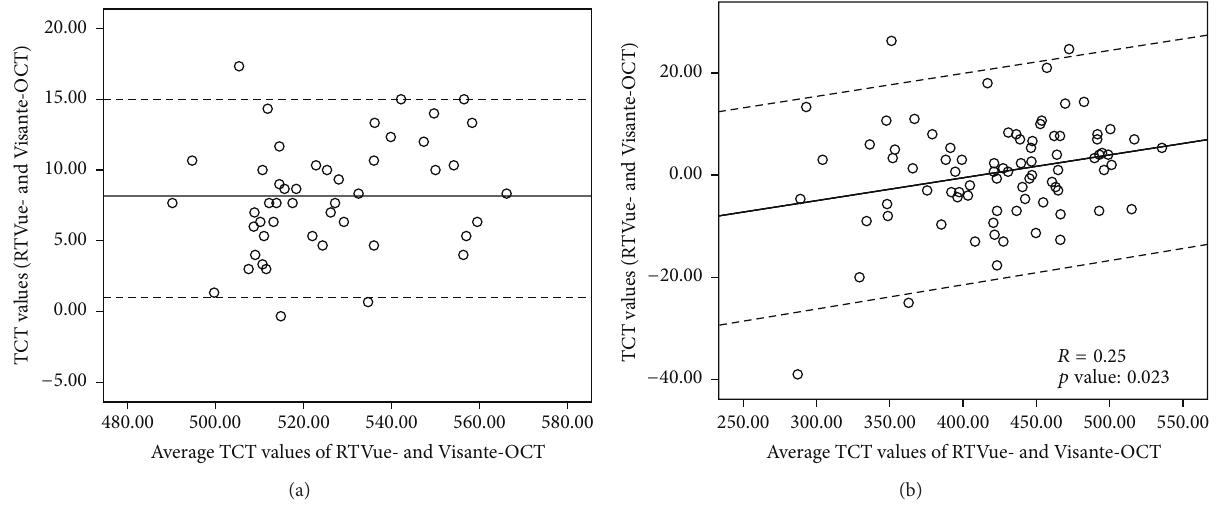
Figure 3: Bland-Altman plots showing the agreement between the RTVue-OCT and Visante-OCT measurements of the TCT. (a) Normal eyes. (b) Keratoconic